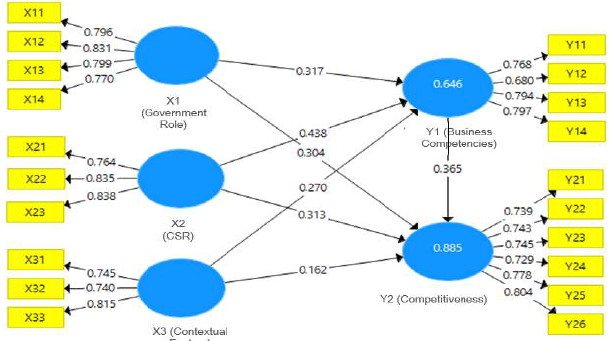
Fig. 1. Full Structural Model of the effect of government role, CSR implementation, contextual factors and business competency on the competitiveness of Wood Crafts SMIs in Bali Province Based on the statistical results, it can be seen that all exogenous variables and constructs have direct effects on endogenous variables with positive relationships when the level of significance is five percent. Respondents' Perception of Competitiveness Latent Variables Total (percent) Indicator